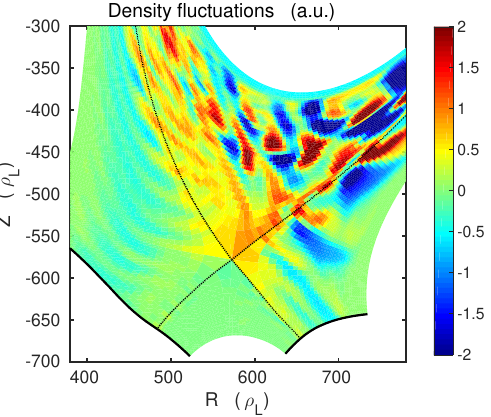
Figure 3. Snapshot of density fluctuations in a COMPASS-like diverted simulation, with zoom on the divertor